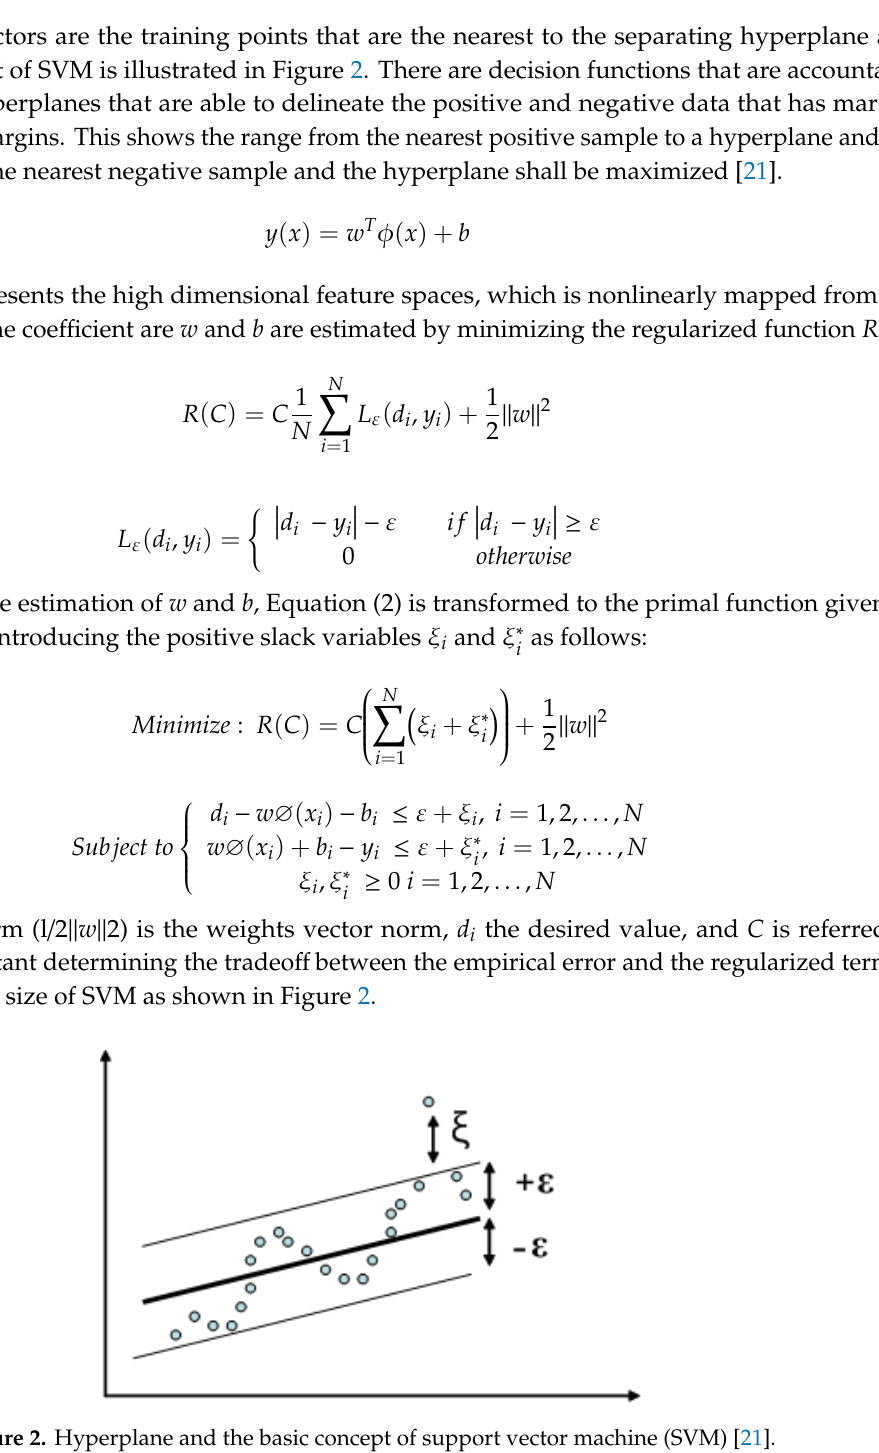
Figure 2. Hyperplane and the basic concept of support vector machine (SVM) Figure 2. hyperplane and the basic concept of support vector machine (SVM) [21].